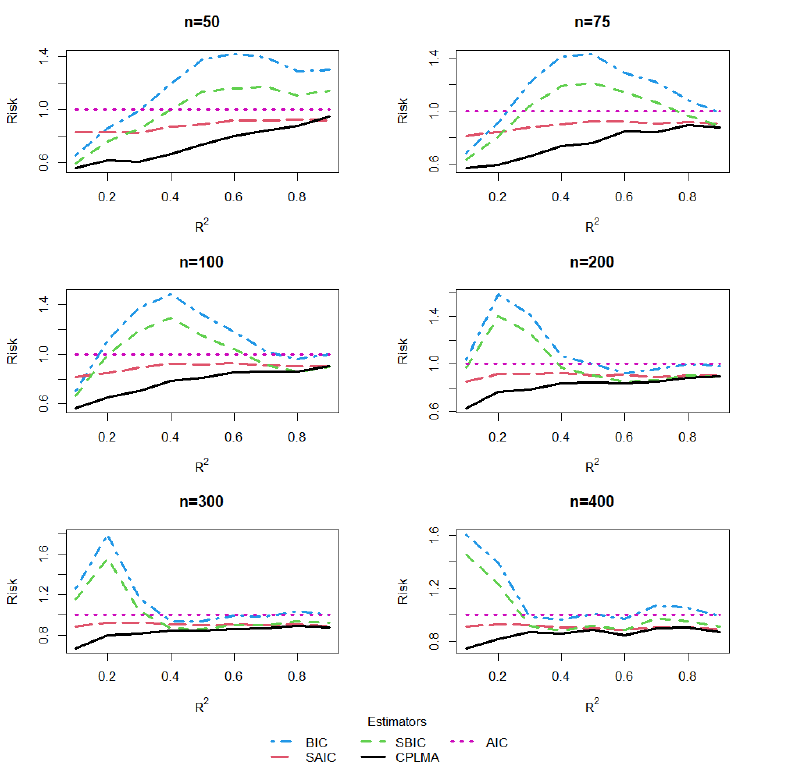
Figure 8. Risk comparisons for Design 2 when α = 2 and the censoring rate is about